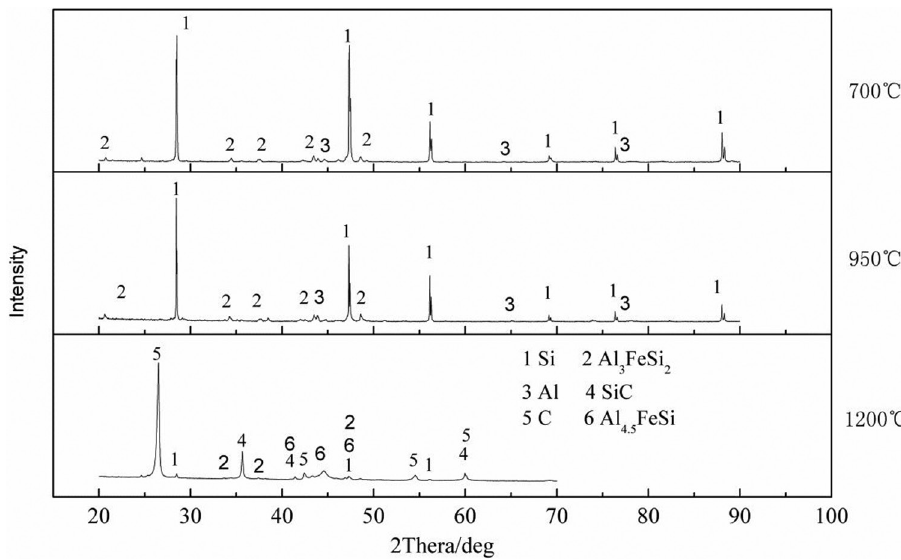
Figure 4: Heating phase diagram of 12.5 wt% aluminum powder and ferrosilicon